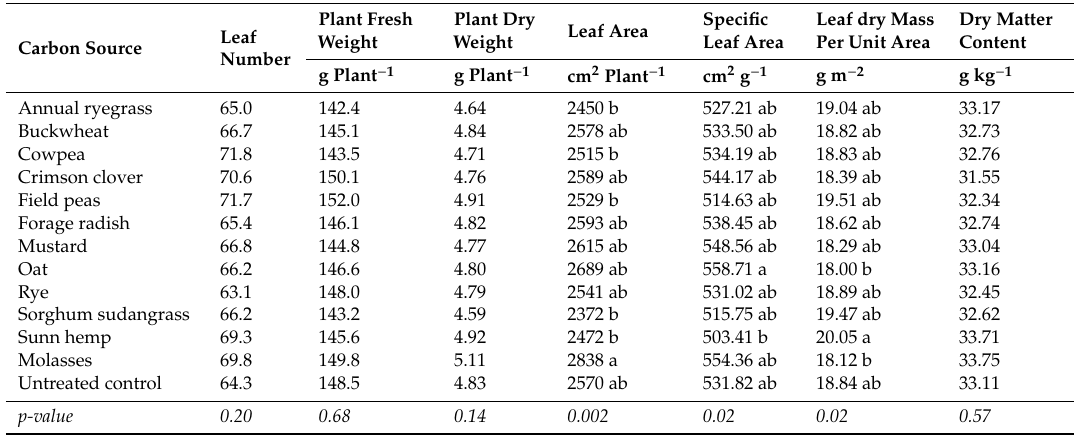
Table 7. Lettuce biometric assessment after 24 days from transplanting 1